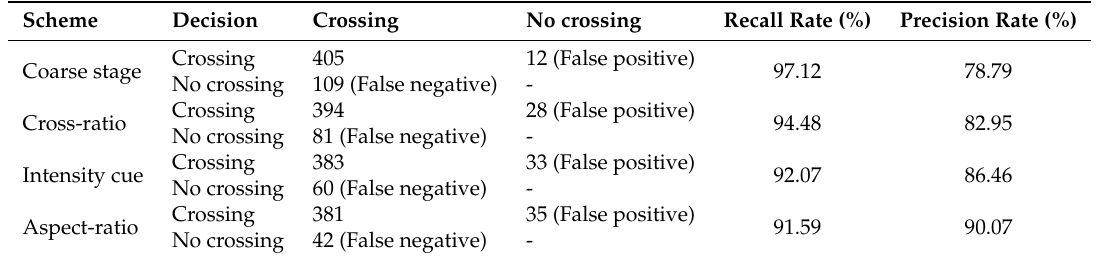
Table 1. Summary of pedestrian crossing detection results at different steps on